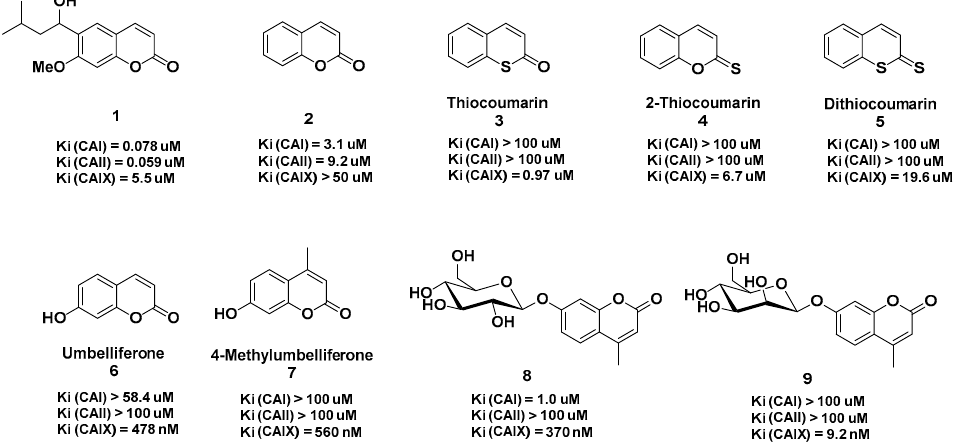
Figure 1. The reported coumarins and derivatives.